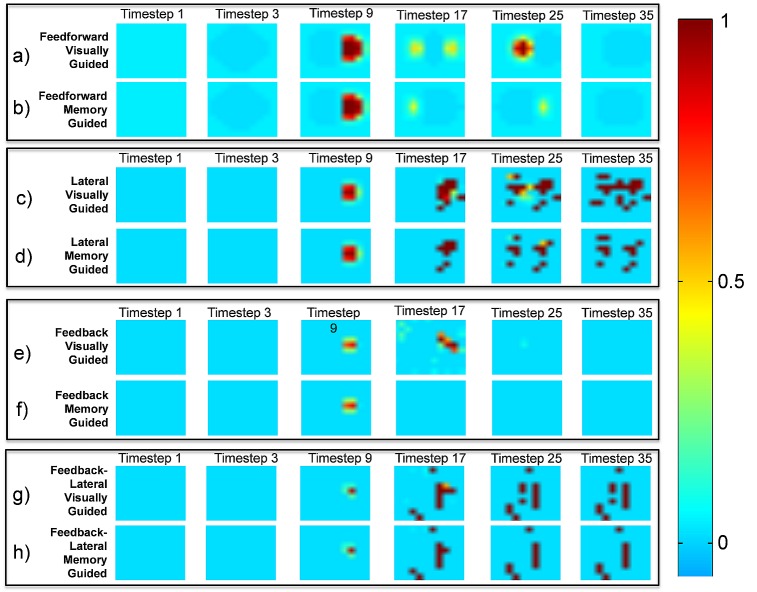
PPC Neural Firing Across a Trial.All plots show a 2-D arrangement of all 121 (11x11) PPC neural firing rates at the timesteps labeled over the columns (from left to right: 1, 3, 9, 17, 25, and 35) for a target located 25 degrees of visual angle to the right of central fixation and the initial hand position. Each pixel is a single PPC neuron’s firing rate at the labeled timestep. The champion agents are shown for the Feedforward, Lateral, Feedback, and Feedback-Lateral models on both the VG and MG tasks. The color bar shows the level of neural activity of the PPC neurons. a) FF model’s champion agent for the VG task. b) FF model’s champion agent for the MG task. c) LAT VG task. d) LAT MG task. e) FB VG task. f) FB MG task. g) FBLAT VG task. h) FBLAT MG task. Compare 6a to 6b and 6c to 6d of the last three columns to see how the models’ PPC neurons fired differently for the two tasks. Compare 6b to 6d (MG task) for timesteps 17, 25, and 35 (columns 4–6) to see how the LAT model was able to reach the target in the absence of a visual stimulus, but the FF model was not.